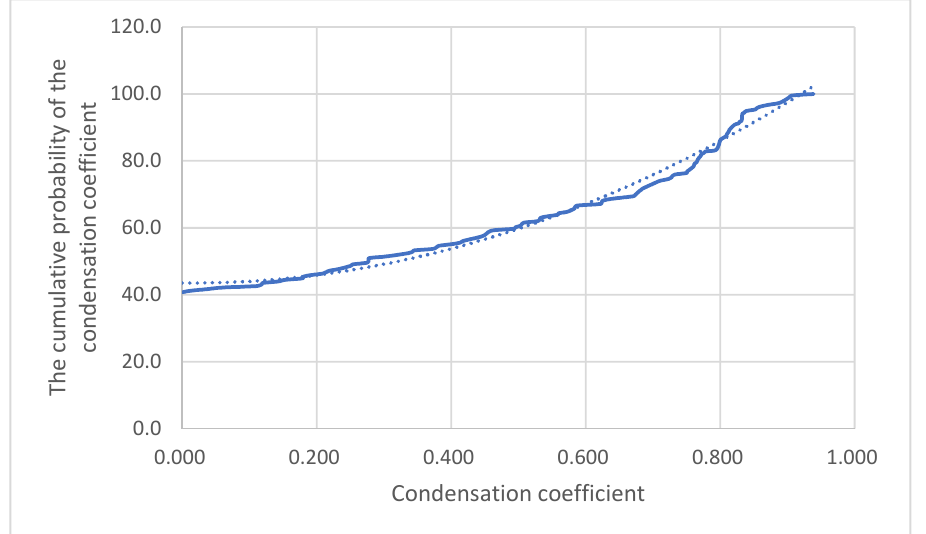
Figure 7. The probability distribution of the condensation coefficient.